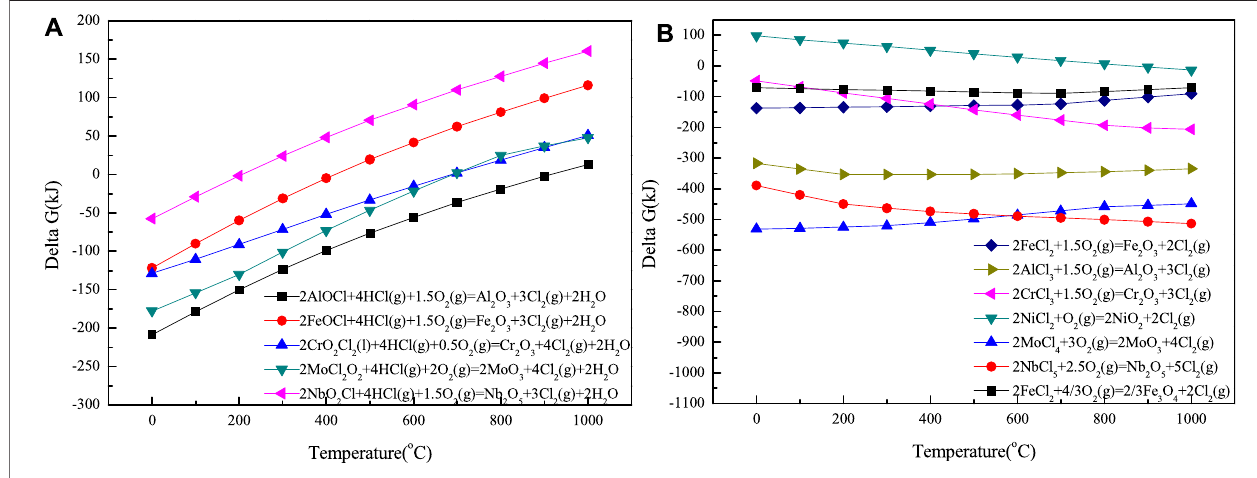
FIGURE 5 | Temperature dependence of Gibbs free energy of oxidation reaction of MClx and MOxCly calculated by HSC6.0: (A) for MOxCly; (B) for MClx.